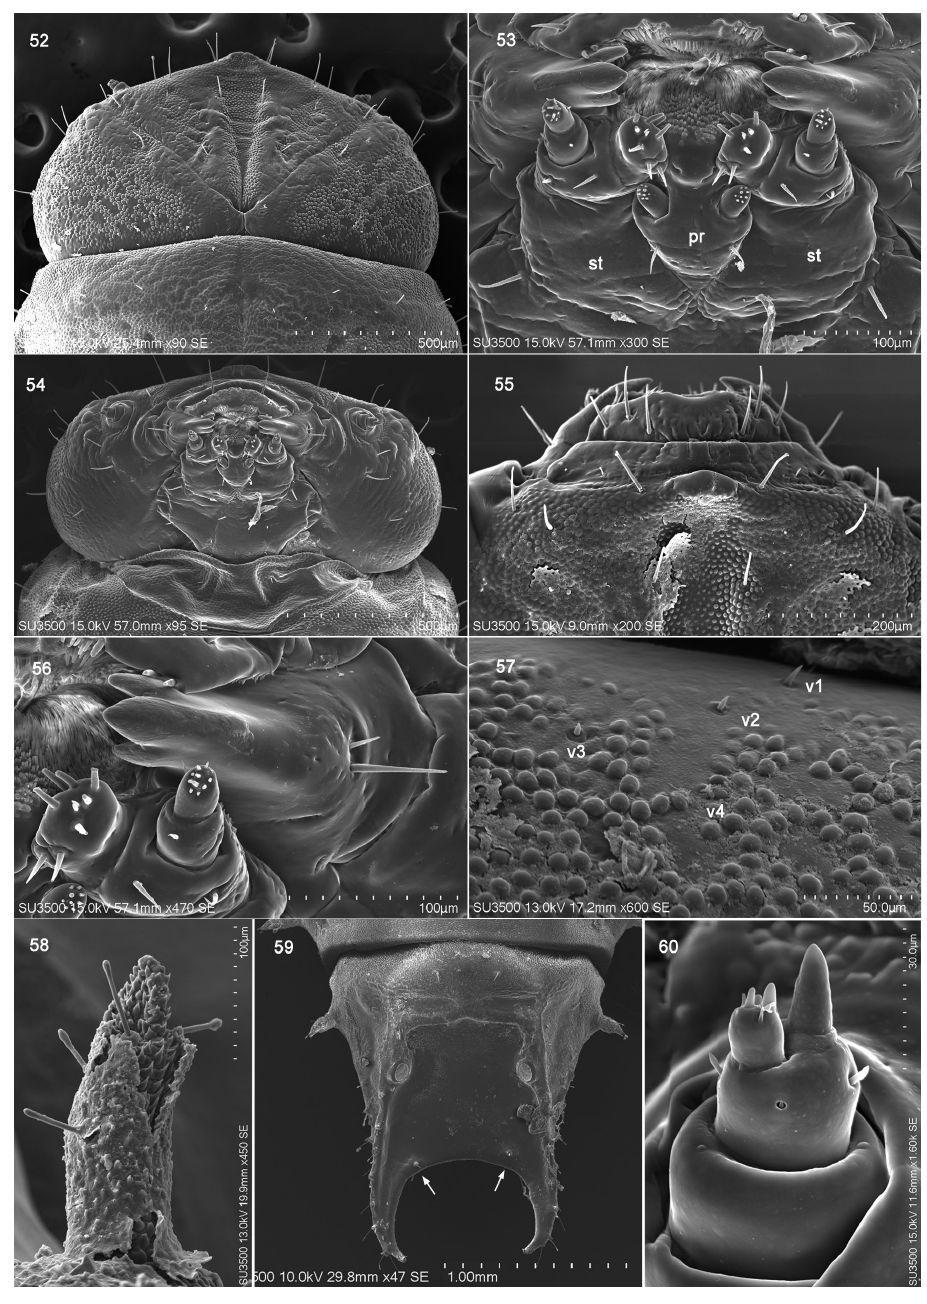
Figures 52–60. Brontispa longissima (Gestro). 52 head, dorsal view 53 mouthpart, ventral view 54 head, ventral view 55 clypeus and labrum 56 mandible 57 vertical setae of head 58 scolus 59 supra-anal process 60 antenna. Abbreviations: pr – prementum; st – stipes; v – vertical